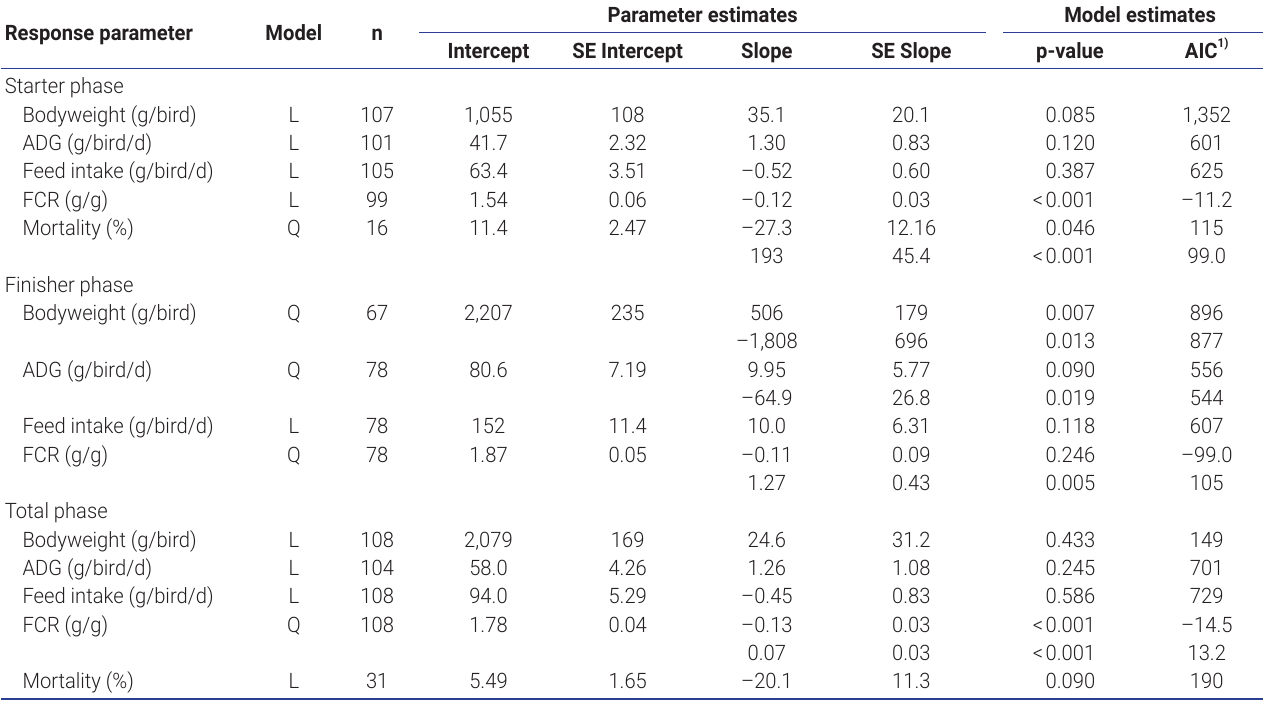
Table 2. Regression equations on the influence of flavonoid-rich herb addition (in % of diet as fed) on production performance of broilers